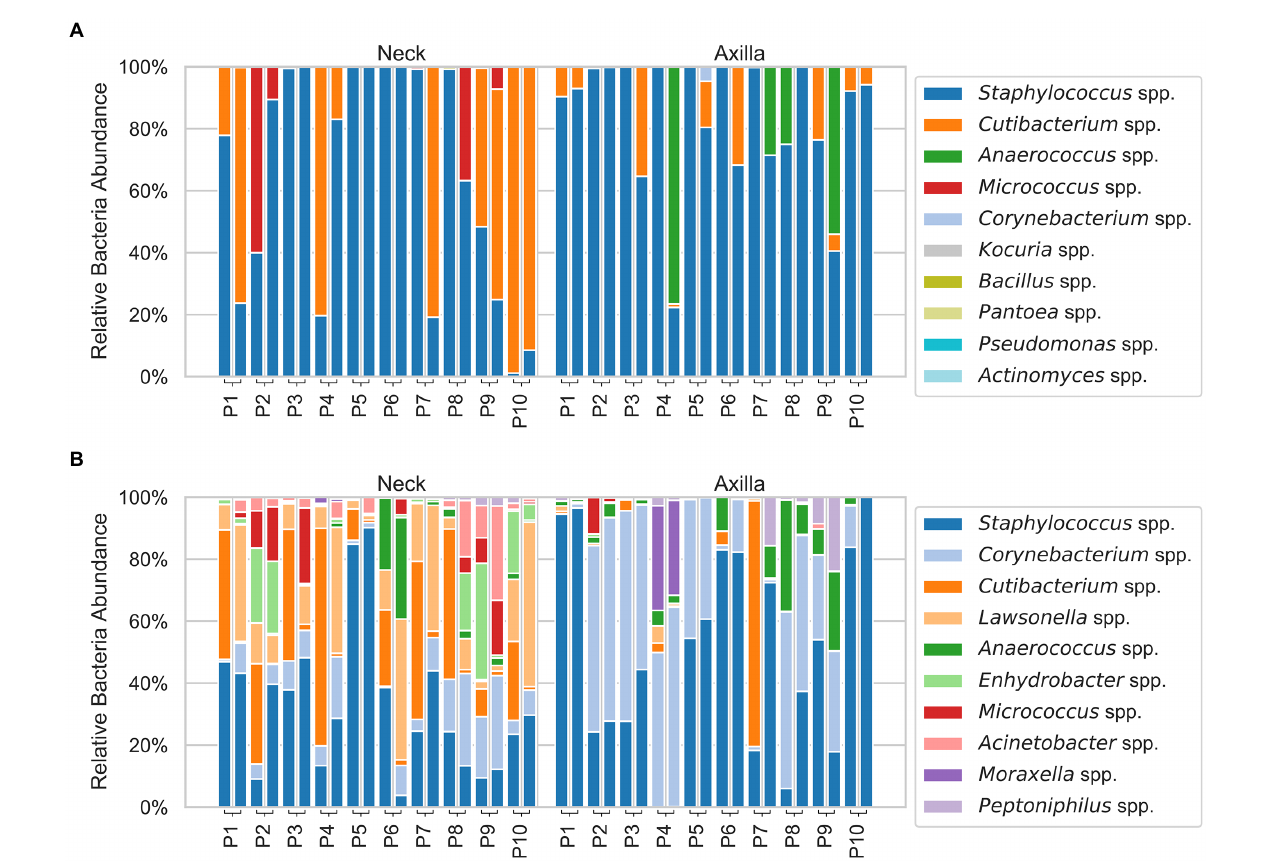
FIGURE 2 Stacked bar plots of the analyzed microbiome with the cultural (A) and DNA approach (B) , showing the relative abundances of the ten most abundant bacteria in the neck (left) and armpit (right) samples. The difference of sampling day 1 and 2 is represented by the two stacked bar plots connected to each participant. Note that only the ten most abundant bacteria are shown and the relative/normalized abundance on the y-axis is given with respect to those ten only (i.e., 100% abundance refers to the top ten and not to all bacteria found for the respective participant). In the cultural approach, abundance of several genera was so low that they are not visible in the bar